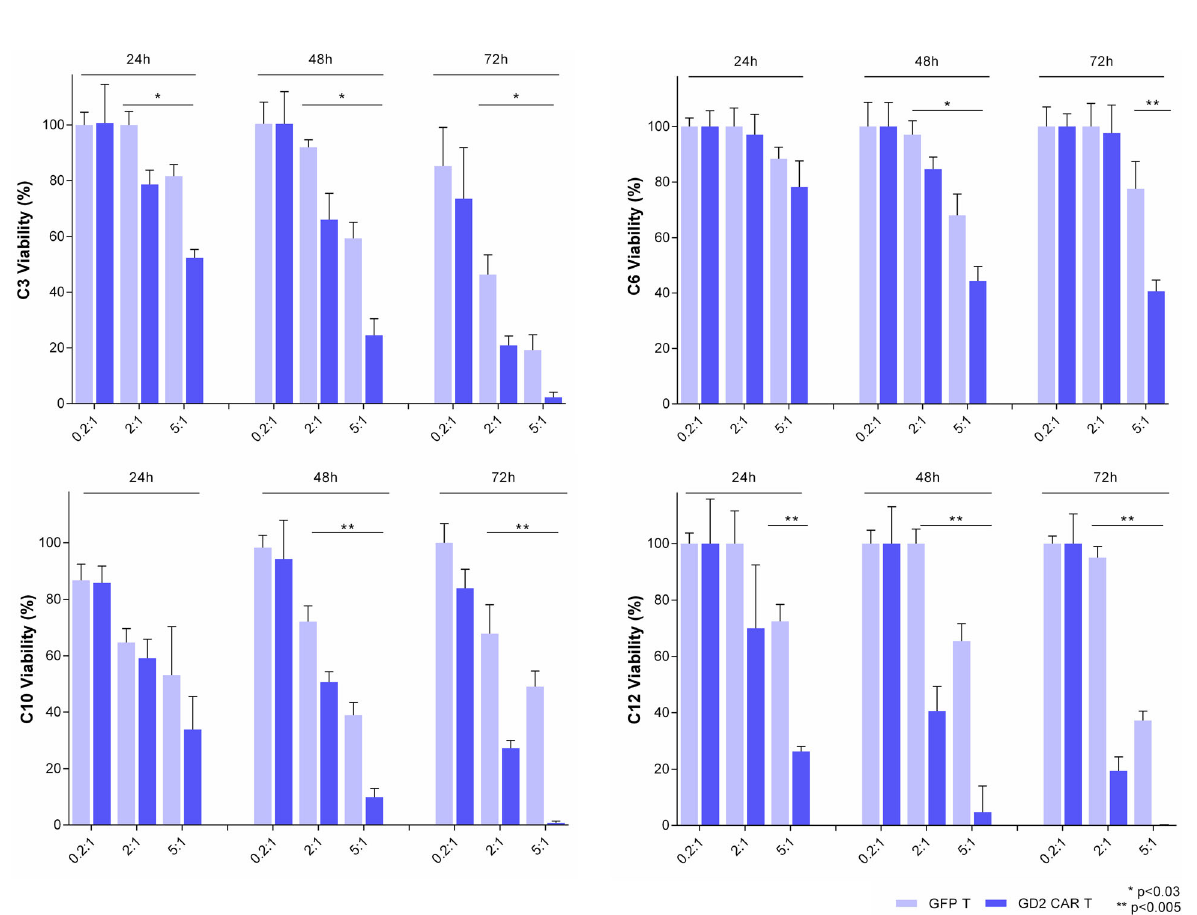
Fig. 2 GD2 CAR T cells exert speci fi c killing in a time- and dose-dependent manner against several GD2 high patient-derived primary glioblastoma cells. Glioblastoma cells (dsRED C3, dsRED C6, dsRED C10, and dsRED C12) co-cultures with GD2 CAR T and GFP control T cells at three different E:T ratios. After 24, 48, and 72 h tumor viability is calculated by fl uorescence viability assay as reported in “ Methods ” . Representative bar graphs from PBMC donor #4 are reported. Data are shown as mean ± SD from six technical replicates; p values are calculated by unpaired two-tailed t